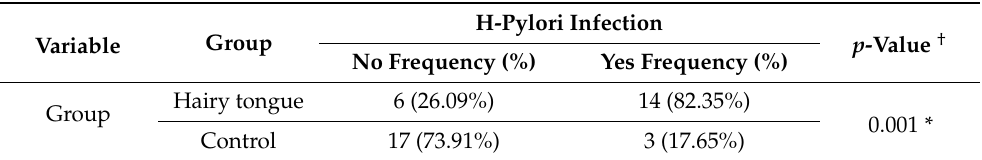
Table 4. Evaluation of the association between the presence of the hairy tongue lesion and the infection of the